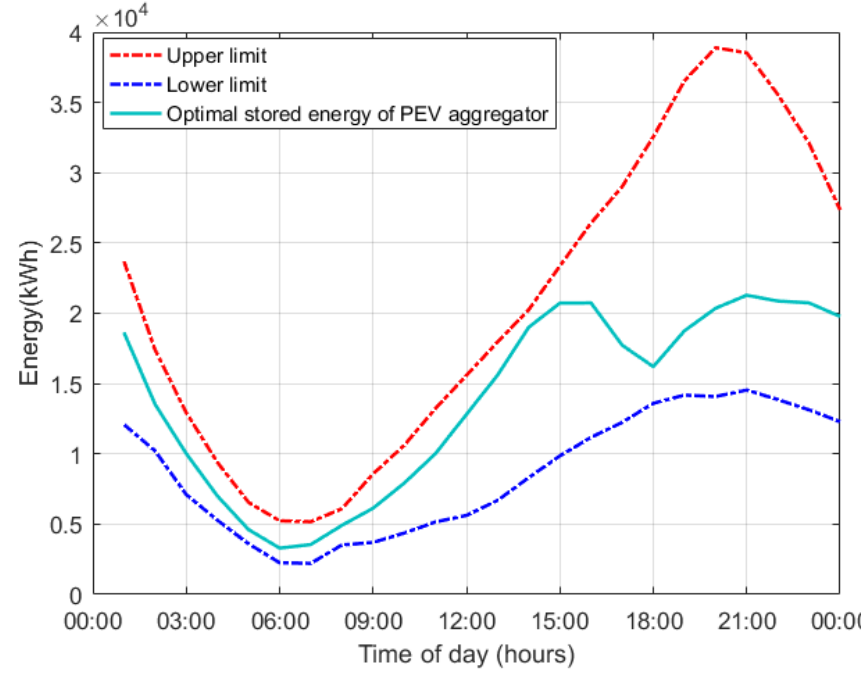
Figure 15. Total stored energy of PEV aggregator and its upper and lower bound.